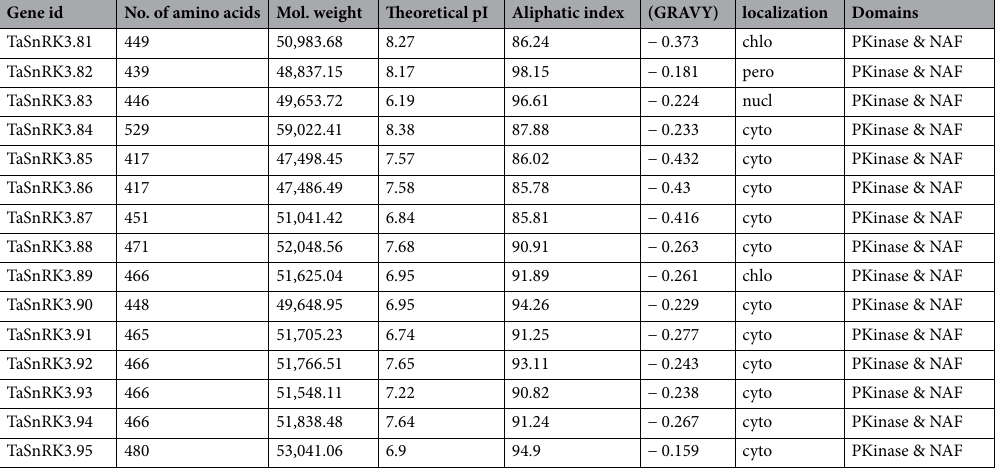
Table 1. List of the identified TaSnRK family members in T.